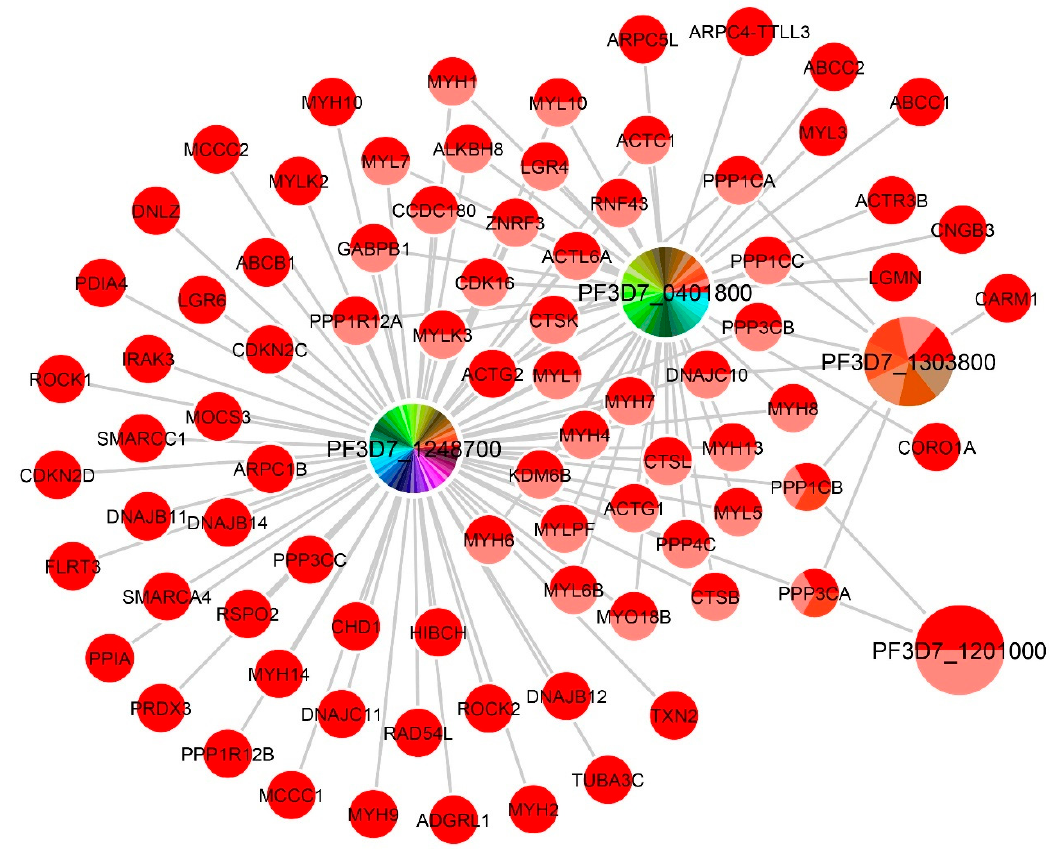
Figure 3. The network of predicted orthologous human genes of four unknown function P. falciparum genes, namely, PF3D7_1248700 , PF3D7_0401800 , PF3D7_1303800 , and PF3D7_1201000 . The pie chart at the node shows the number of neighboring nodes, corresponding to the number of slices. The colors in a node that shows different slices were rendered using the modulated rainbow color scheme. A node with a large number of colored slides indicates a large number of its neighboring nodes.